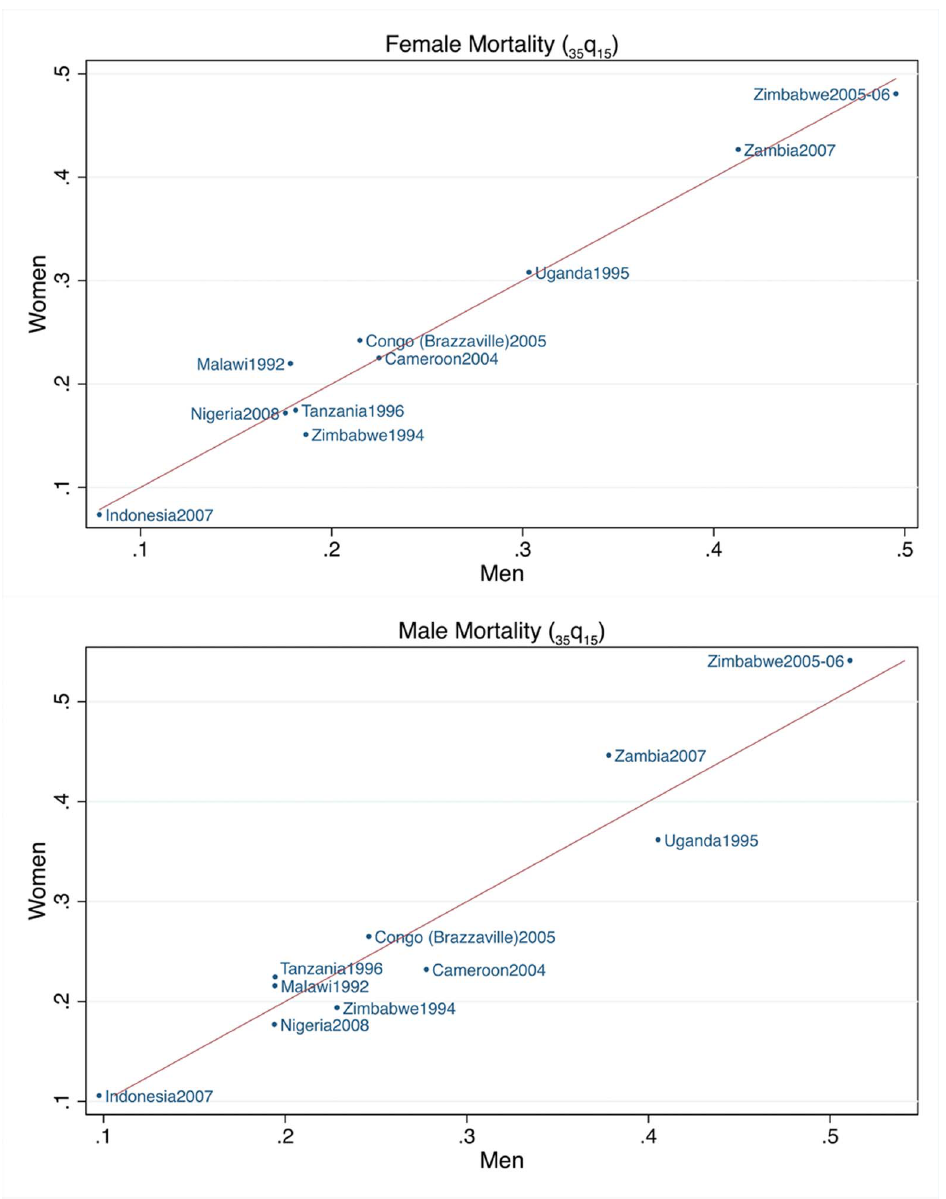
Figure 1. Comparison of the female and male probabilities of dying ( 35 q 15 ) obtained from sibling histories reported by women and men for the 1–5 calendar years preceding the survey.